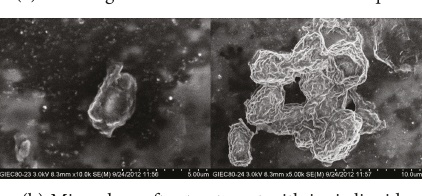
(a) Microalgae before treatment with ionic liquid